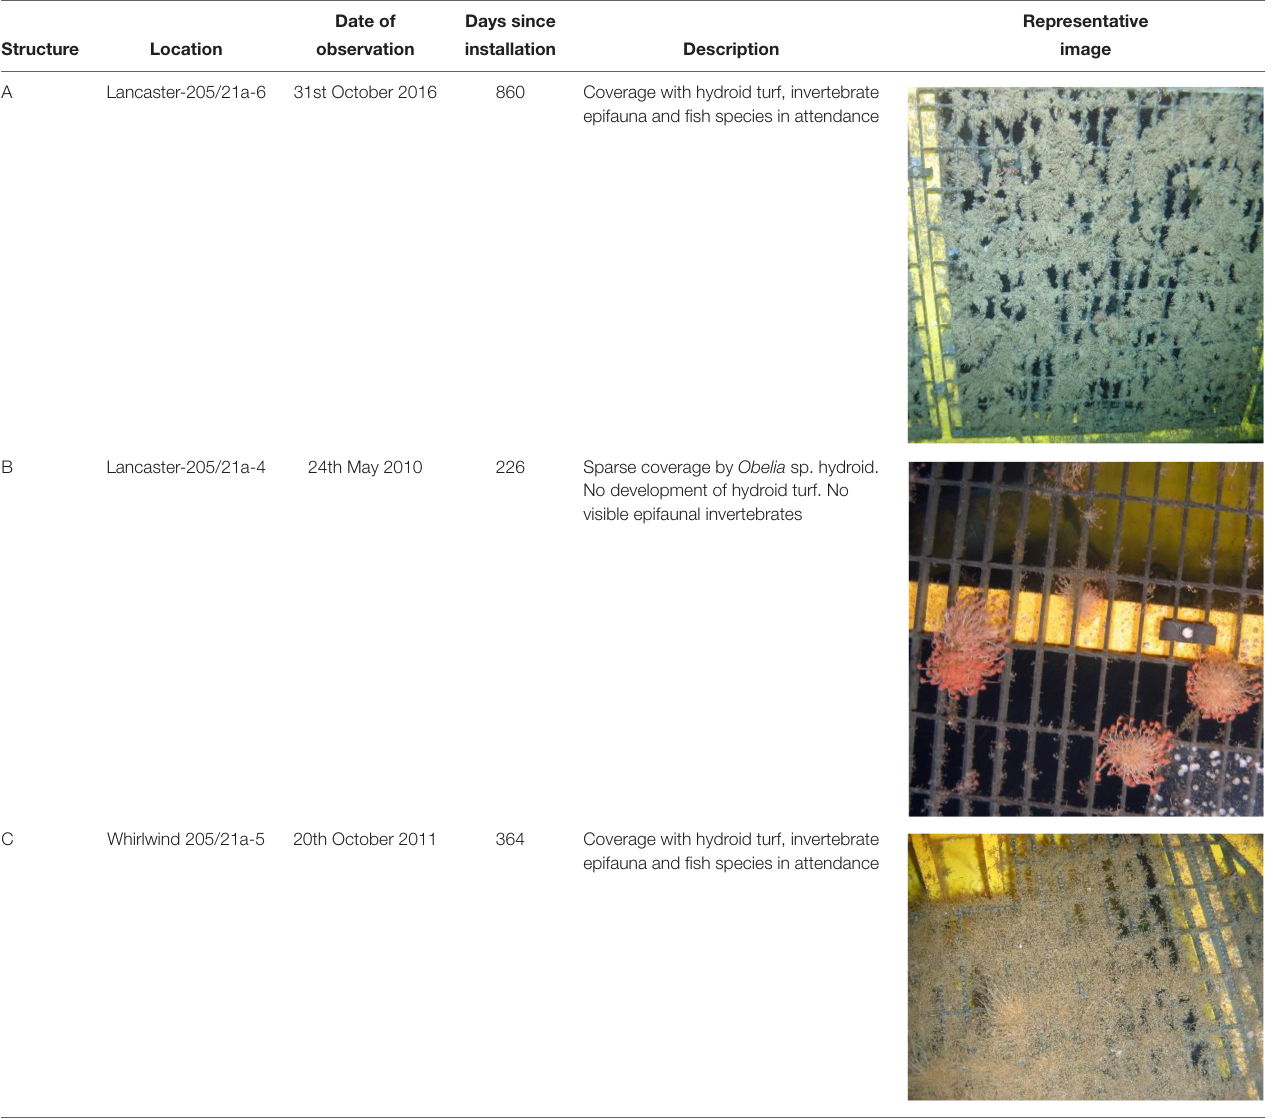
TABLE 3 | Details of the three protective structures considered here.